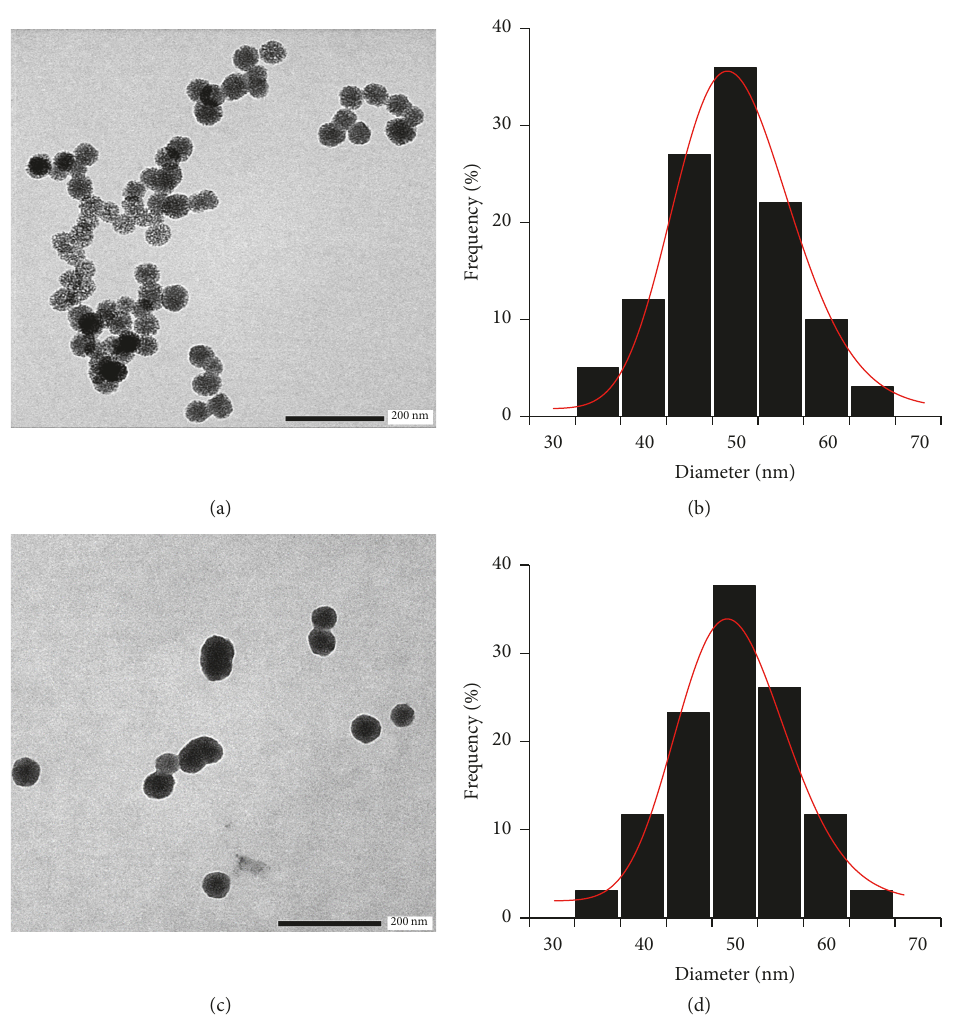
Figure 6: TEM images and particle size histograms: PNS (a, b); PNS-SS-ADA@CD-mPEG (c, d) fitted by log-normal distribution function,